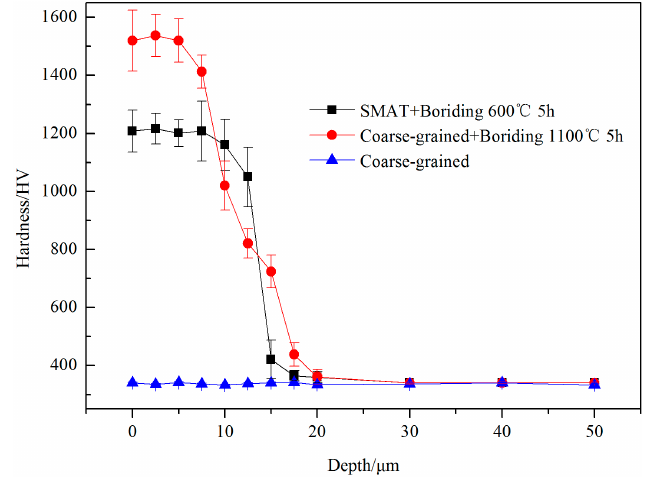
Figure 7. Hardness variations along the depth of both the SMAT boriding sample and the coarse-grained boriding